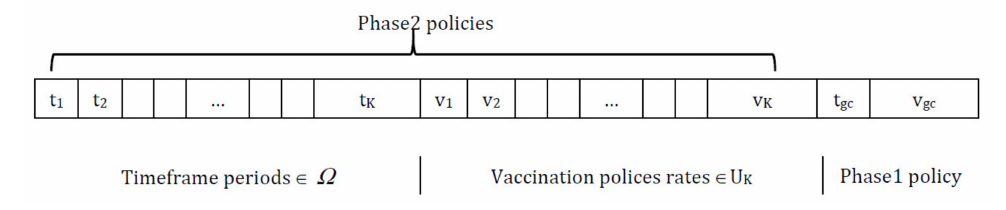
Figure 3. Chromosome